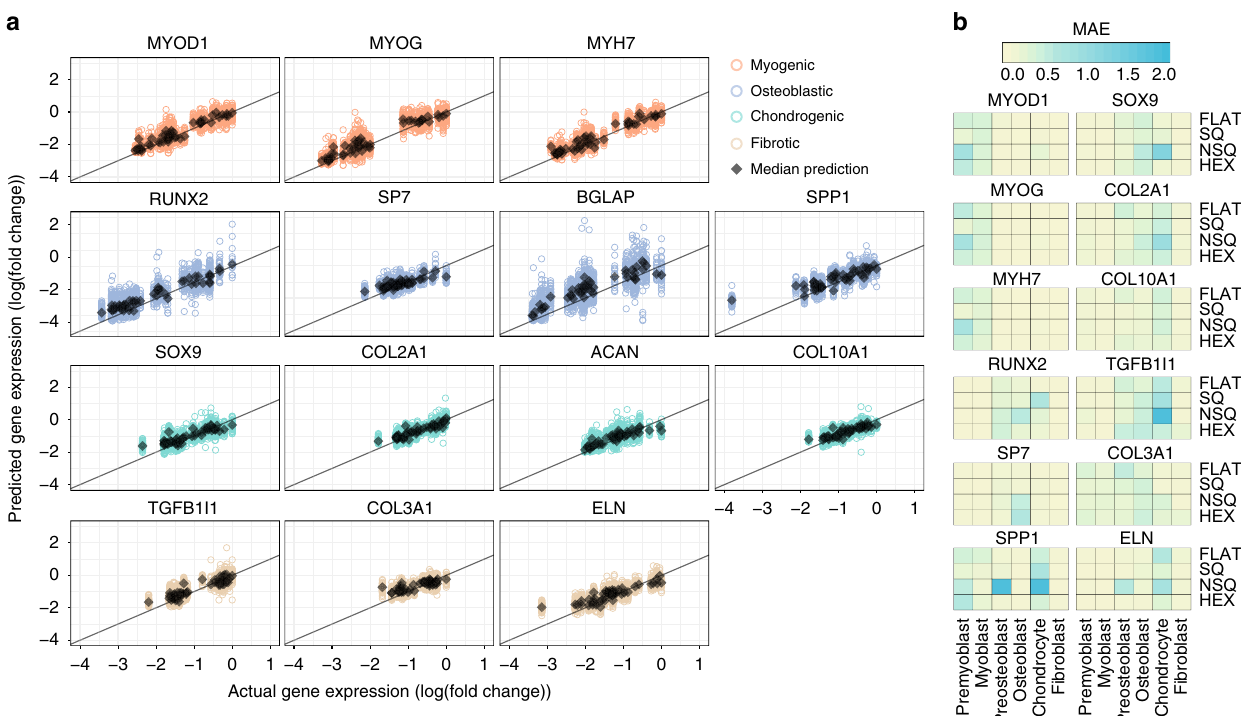
Fig. 5 The morphome reliably predicts nanotopography-induced gene expression. a The morphome was used to train a Bayesian linear regression model that predicted myogenic, osteogenic, chondrogenic, and fi brotic gene expression. The expression of each gene (response) was trained against linear combinations of morphome features (predictors) and without any prior knowledge on topography parameters. The linear regression model was trained using 60% of the dataset and tested using 40% of the data. Scatterplots show actual and predicted gene expression values by using the test set as input to the model, with each open faced circle showing predicted and actual gene expression from a single morphome. Black diamond shows the median predicted gene expression values. Colors represent the different musculoskeletal genes, with orange denoting myogenic, blue denoting osteoblastic, green denoting chondrogenic and brown denoting fi brotic genes. Mean absolute error (MAE) was obtained by fi rst calculating the difference between actual and predicted gene expression values for each morphome then averaging differences across the entire morphome. b Testing the predictive power of the morphome by leave-one-out validation. To test the predictive power and bias of the morphome, the linear regression model was retrained after exclusion of one combination of cell type and topography. The excluded cell type and topography dataset was used for prediction, from which MAE was calculated. The tile position denotes the cell type and nanotopography combination that was excluded in the model and used for testing, while the color of each tile denotes the